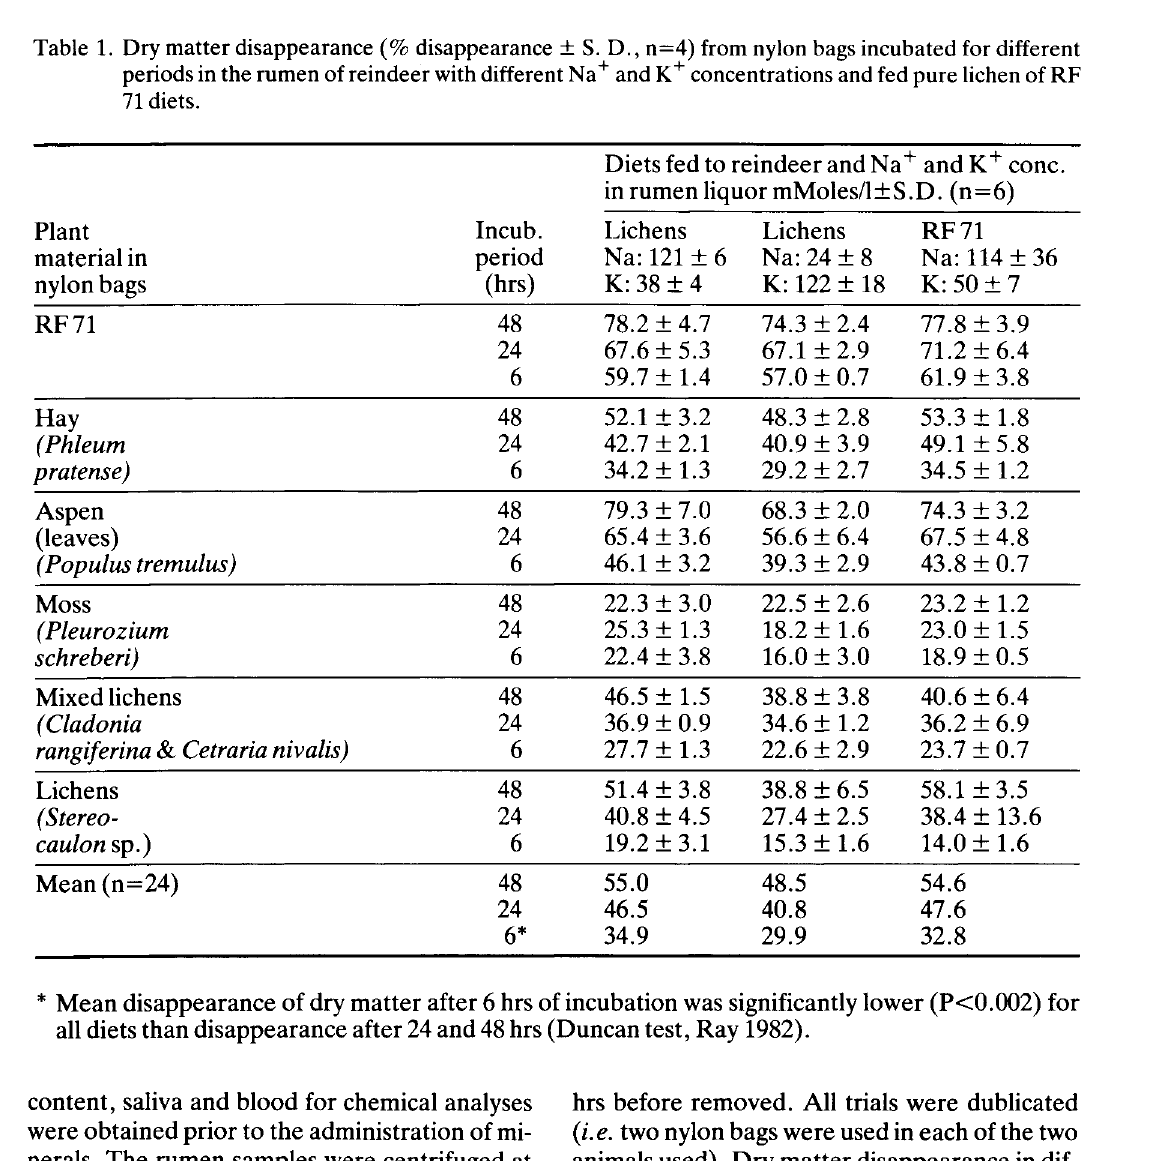
Table 1. Dry matter disappearance (% disappearance ± S. D., n=4) from nylon bags incubated for different periods in the rumen of reindeer with different Na + and K + concentrations and fed pure lichen of RF 71